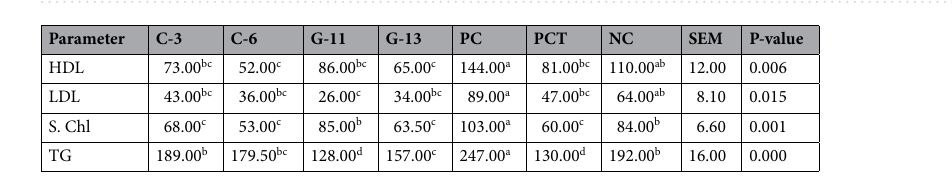
Figure 4. Graphical presentation blood glucose level (mmol/l) of positive control and negative control group compared with, ( a ) probiotic strain C3, ( b ) probiotic strain C6, ( c ) probiotic strain G11, ( d ) probiotic strain G13 and ( e ) Positive control treated with metformin (PCT).